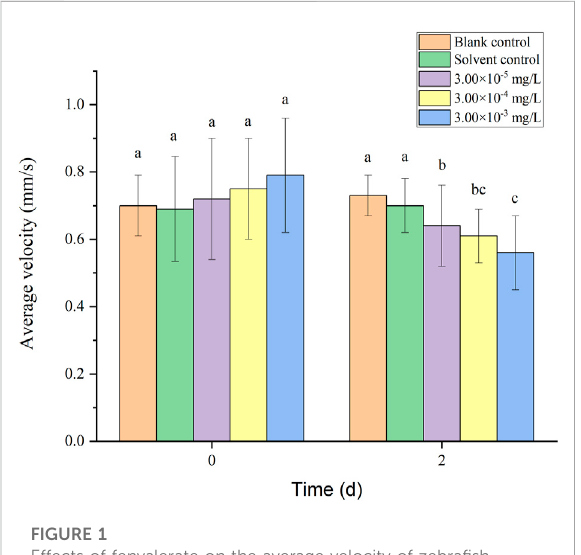
FIGURE 2 Effects of fenvalerate on the average acceleration of zebra fi sh larvae